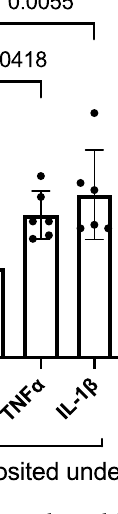
Figure 5. ECM derived from TNFα- or IL-1β-treated hRP causes increased PBMC adhesion. Naïve hRMEC monolayers were plated onto ECM derived from TNFα- or IL-1β-treated hRP. PBMC were added to naïve hRMEC, allowed to adhere, and washed to remove non-adherent cells. Adherent PBMC were counted in 3 regions per well and averaged. Average counts were then divided by count area. Data are reported as fold induction over vehicle with bars representing mean ± SD (vehicle: n = 6; TNFα: n = 6; IL-1β: n =